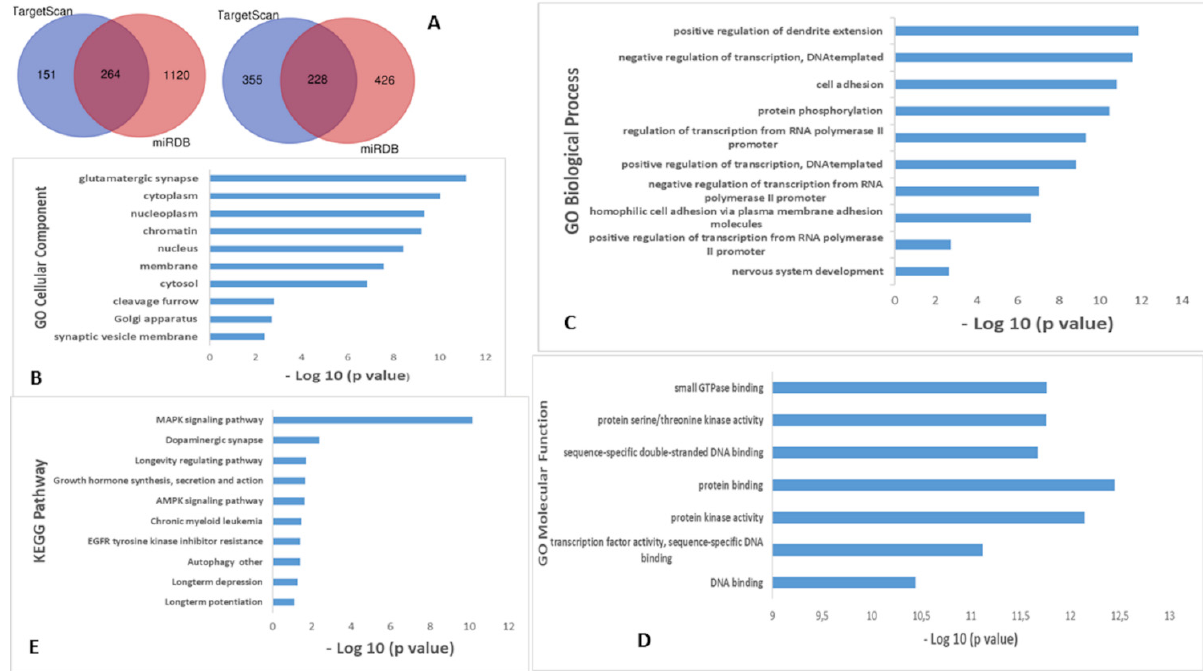
Figure 4. miRNA target and pathway prediction for miR-133a-3p and miR-106b-5p. ( A ) Venn diagram of target genes of two significant svPPA miRNAs using two bioinformatic tools; ( B ) GO enrichment analysis demonstrated the top 10 genes enriched in CC, ( C ) BP, ( D ) MF and ( E ) KEGG pathway analysis.